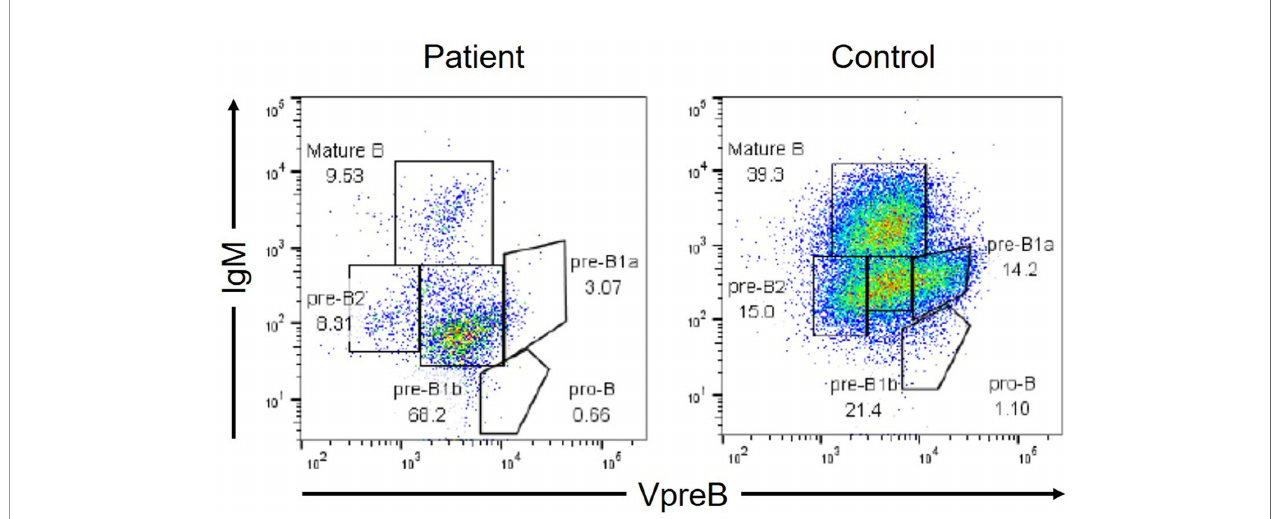
FIGURE 3 | Flow cytometric analysis of B-cell differentiation in the bone marrow (BM). VpreB is a component of the surrogate light chains. The analysis gate was set in CD19 + and/or VpreB + cells. The BM cells were fi xed and permeabilized to simultaneously analyze the cell surface antigens (IgM and CD19) and the intracellular molecule